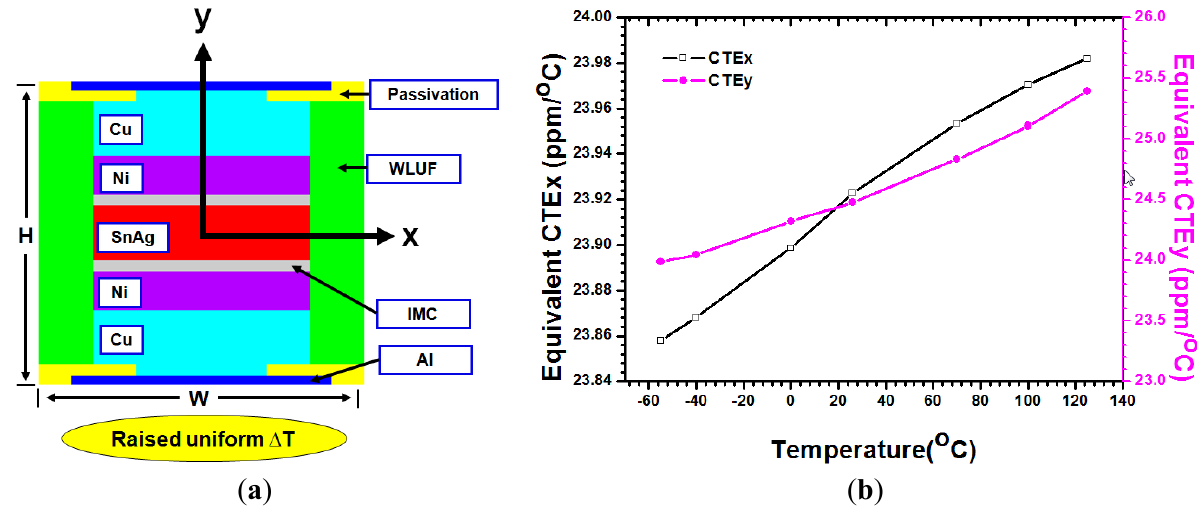
Figure 5. Graphical explanation and temperature-dependent curves for equivalent CTE of a microbump unit with WLUF: ( a ) FEA model of extracting equivalent CTE; ( b ) temperature dependence of CTE x , CTE y